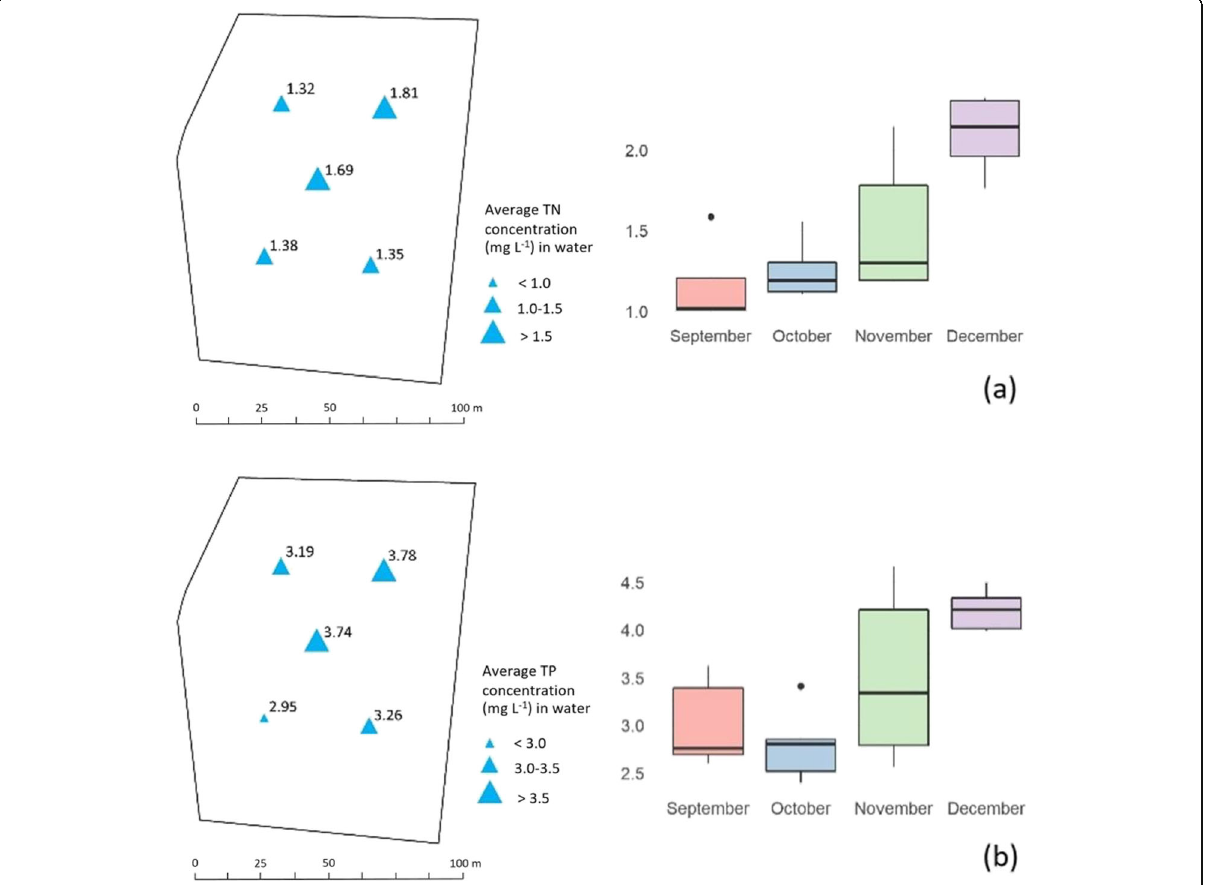
Fig. 4 Spatio-temporal variations of ( a ) total nitrogen and ( b ) total phosphorus in the water during a 90-d crop cycle. Graphical distribution maps present average nutrient values on each sampling location based on four-time sampling in the experiment. Boxplots demonstrates data distribution based on monthly